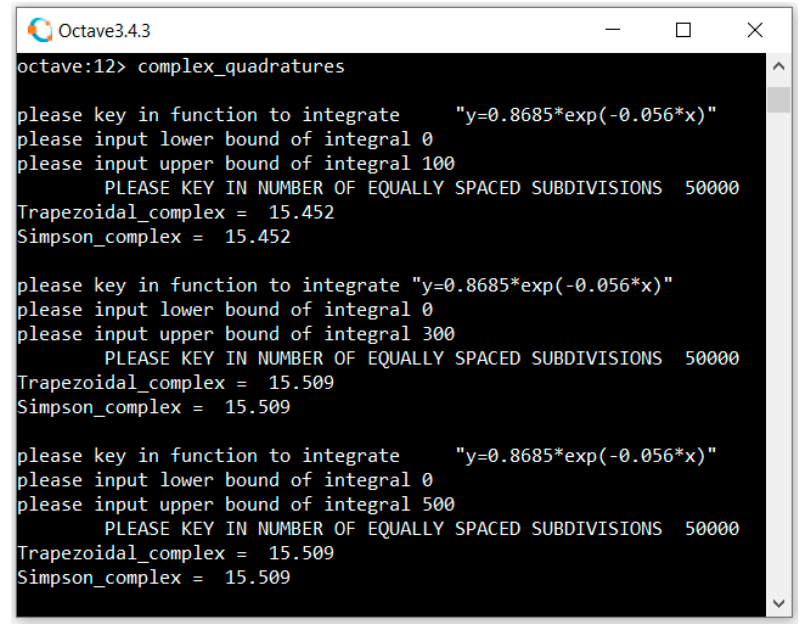
Figure 8. Complex quadrature values depending on the integration interval division.